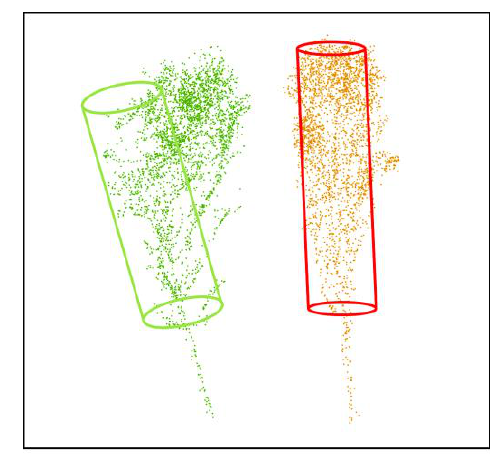
Figure 2. The schematic concept of a DSIT for two trees